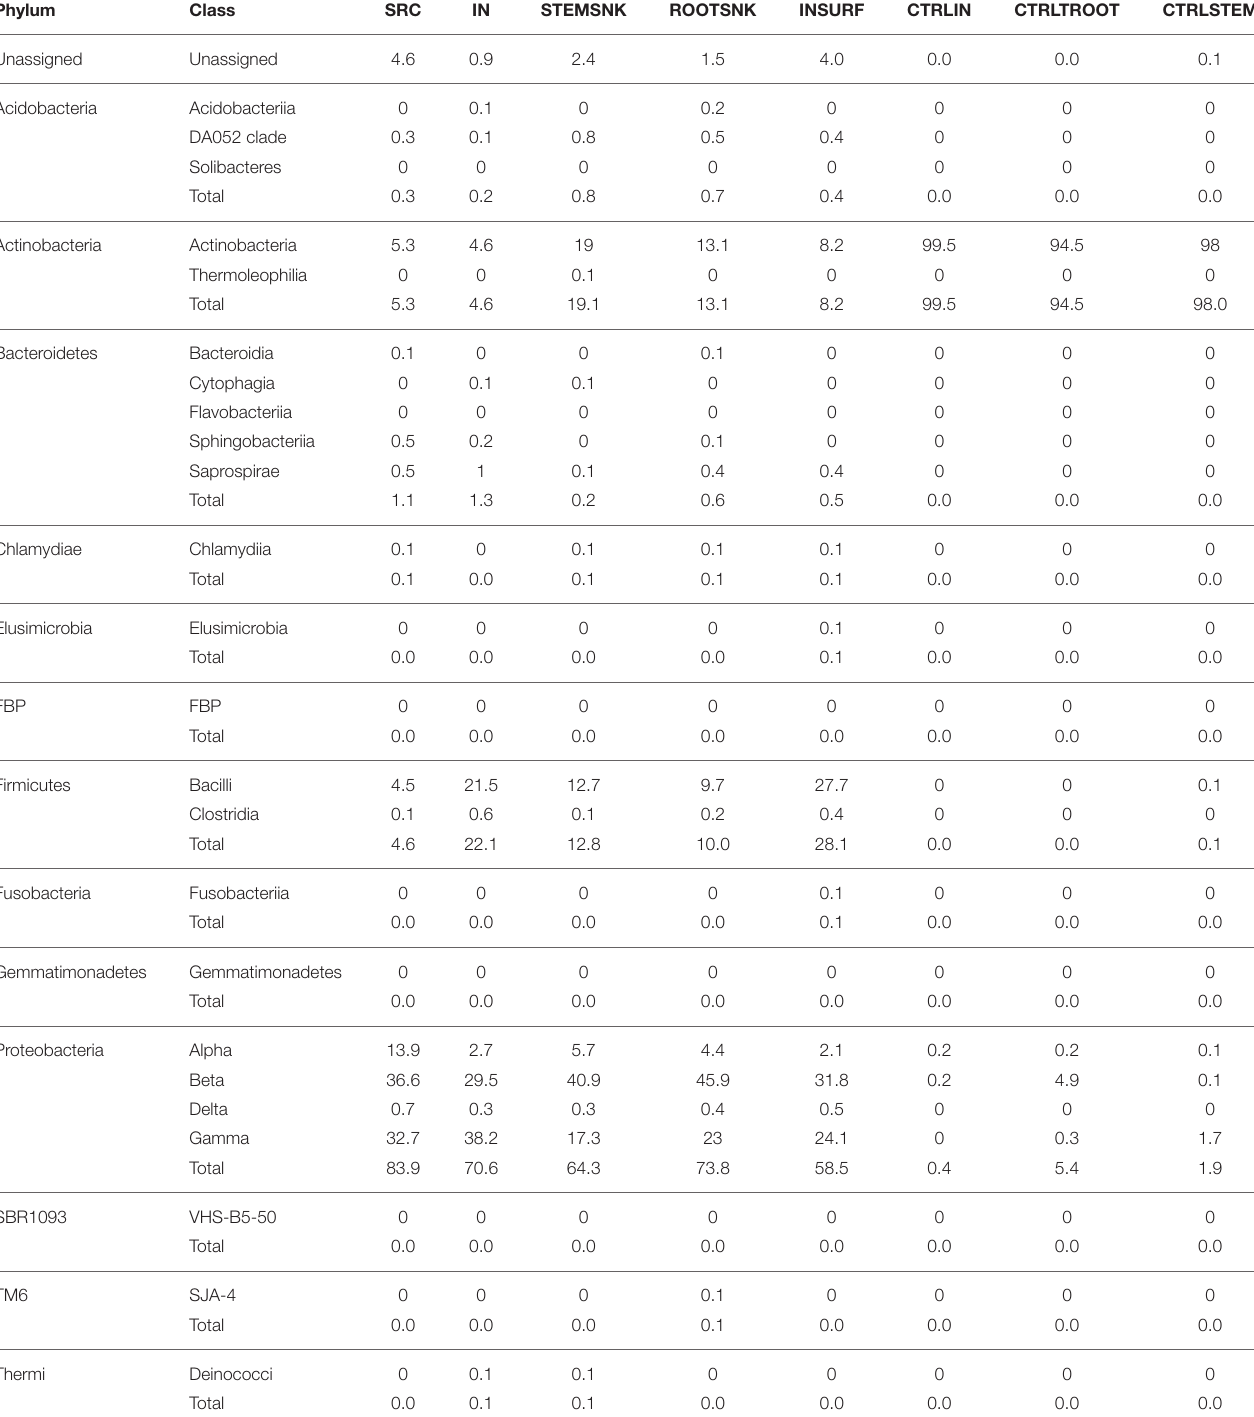
TABLE 1 | Relative abundance of OTUs in the symbiosystem S. titanus —grapevine, assigned at phylum and class level. Phylum